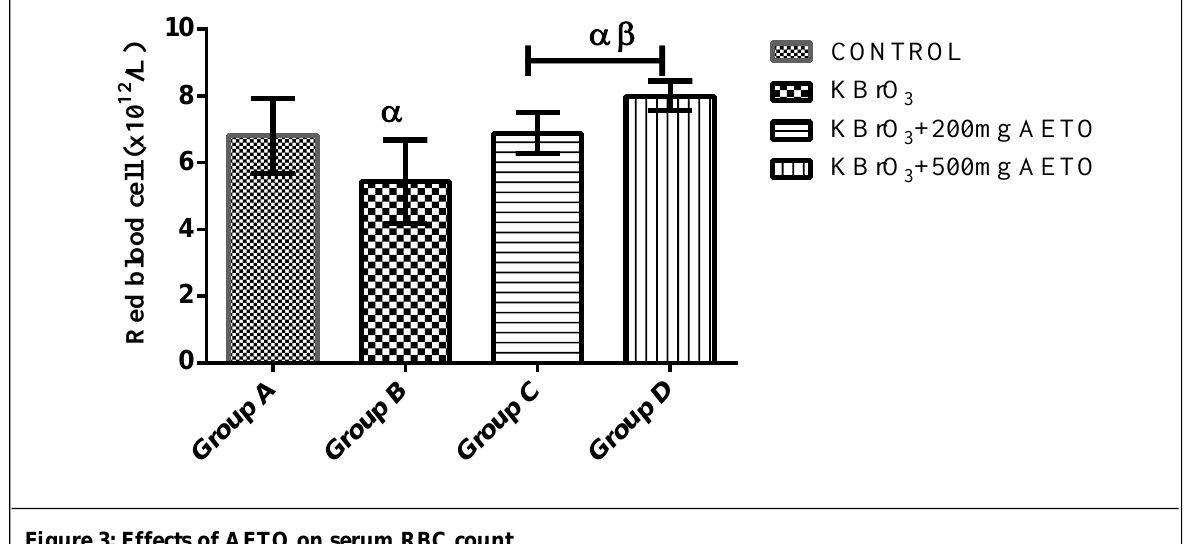
Figure 3: Effects of AETO on serum RBC count Note: Value of p < 0.05 was considered significant. The values with superscript  = significantly different from group A,  = significantly different from group B. RBC – Red Blood Cell.